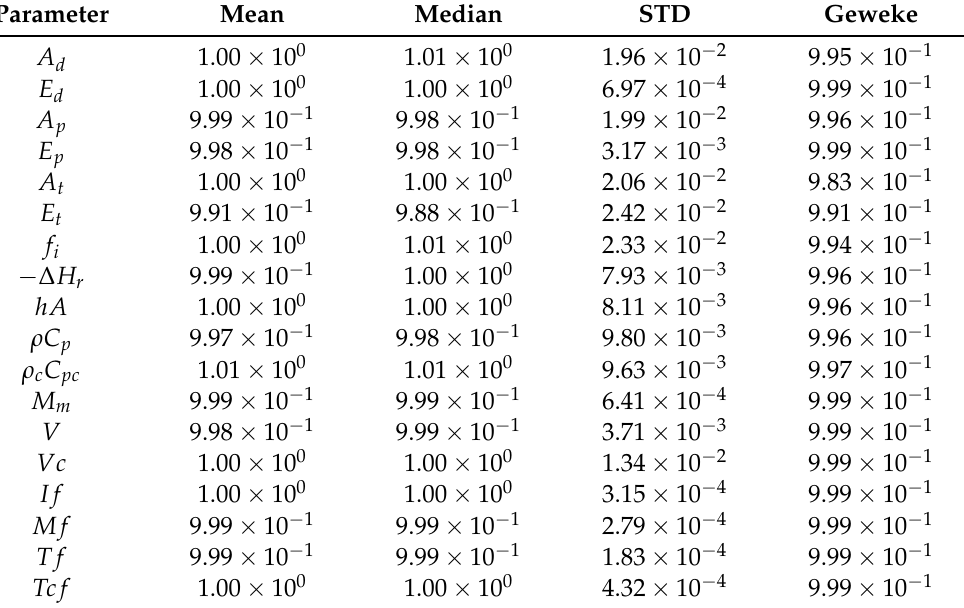
Table 5. Normalized parameters obtained by DRAM algorithm.